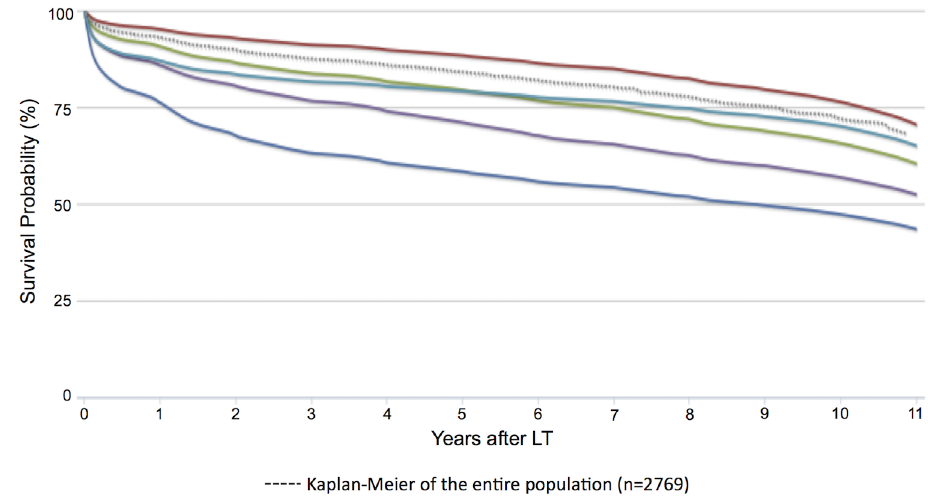
Fig 3. PSSP curves. Example of 5 representative curves, produced by PSSP after a first liver transplantation (solid curves). Each corresponds to a specific patient transplanted for PSC. The dashed curve corresponds to the Kaplan- Meier survival curve of the entire population of PSC patients (n = 2769